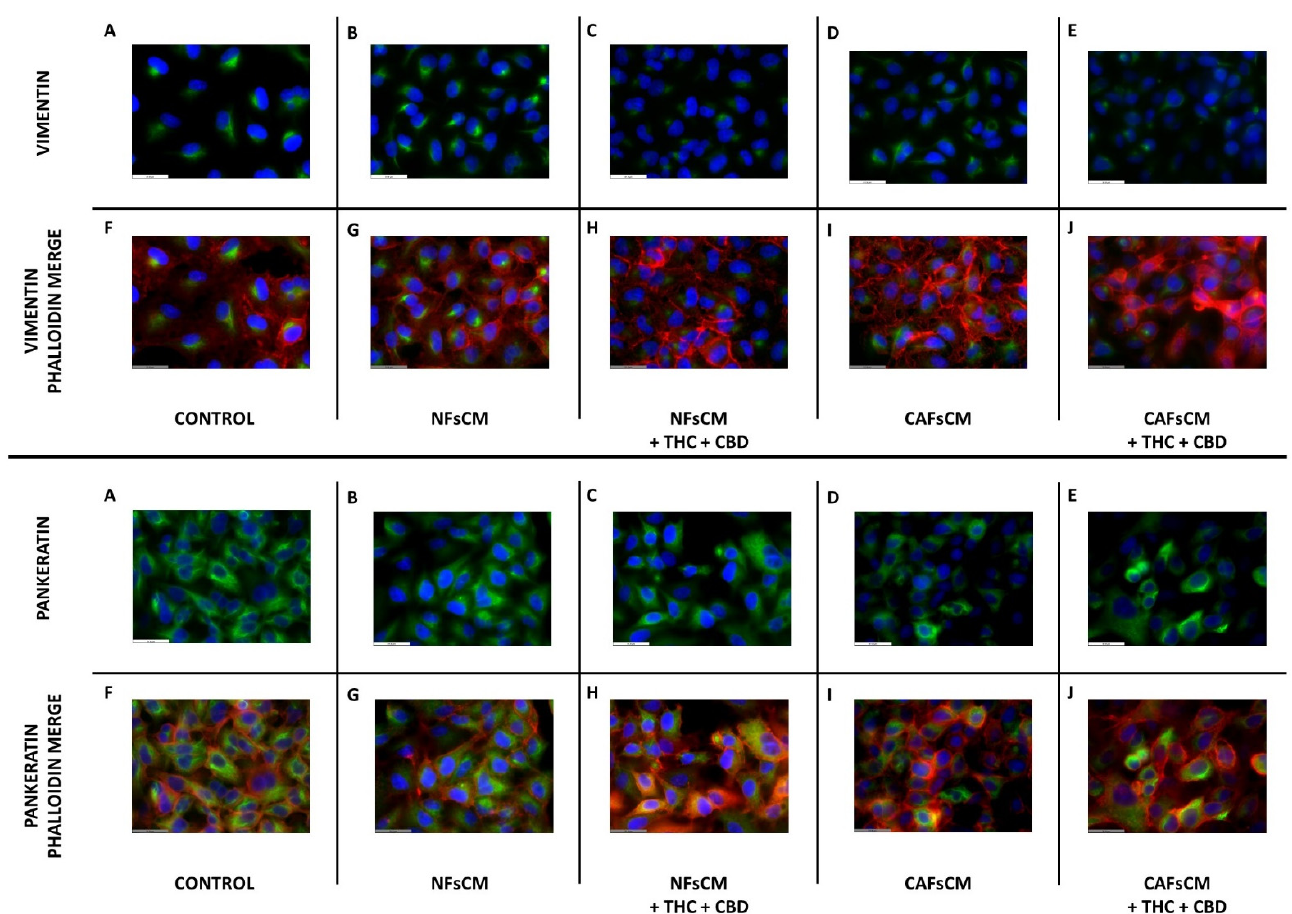
Figure 5. Effect of cannabinoid agonists on A459 cell cytoskeletal changes induced by stromal-cell-conditioned medium. The culture medium was conditioned with NFs (NFsCM) or CAFs (CAFsCM) treated or not with an equimolar mixture of 10 µ M THC + CBD. A549 cells were cultured with non-conditioned culture medium ( A , F ), NFsCM ( B , G ), NFsCM + THC + CBD ( C , H ), CAFsCM ( D , I ) or CAFsCM + THC + CBD ( E , J ) for 72 h. Vimentin and cytokeratin filaments were studied by immunofluorescence. F-actin was evaluated using rhodamine-conjugated phalloidin. Representative fluorescence images corresponding to 3 different experiments are shown. A triplicate was analyzed in each of the experiments. Scale bar is equal to 31.5 µm.